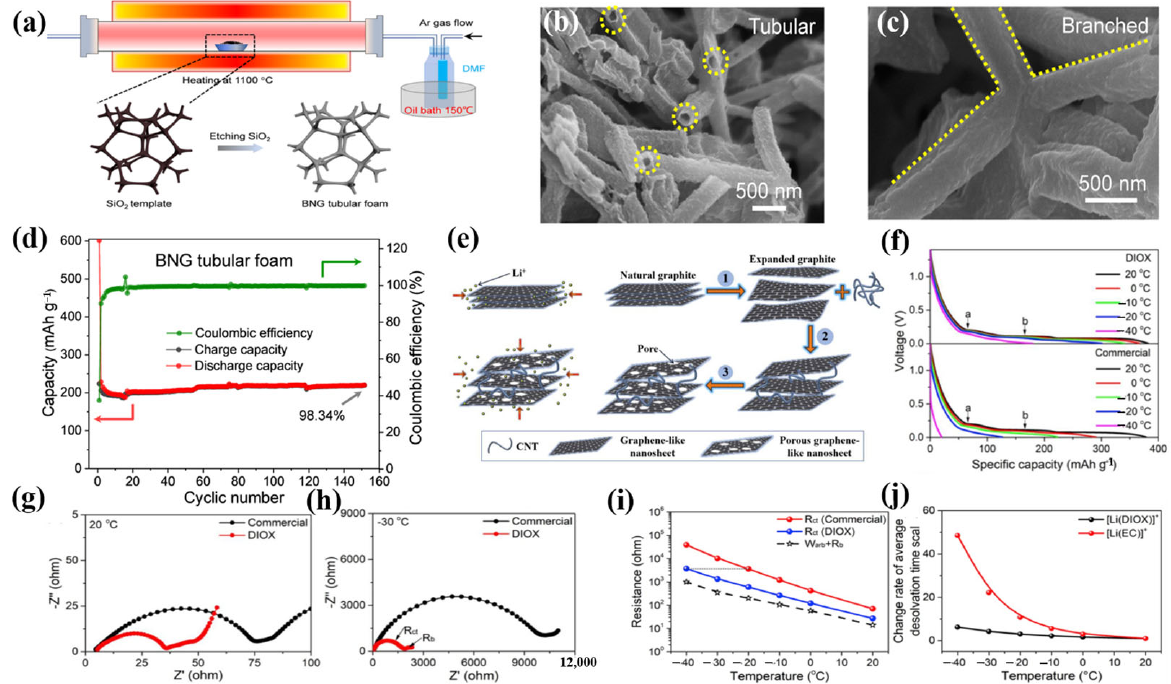
Figure 9. ( a ): Schematic diagram of the preparation of the BNG tubular foam using the self ‐ sacrifice template CVD method. ( b , c ): SEM images of BNG tubular foam. ( d ): Cyclic performance of BNG tubular foam at a current density of 0.1 C. ( a – d ) Reproduced with permission from [89]. ( e ): Sche ‐ matic illustration of the Li + insertion process for natural graphite and porous graphite nanosheet (PGN). ( f ): Voltage vs. Li + intercalation capacity over various temperatures at the 0.1 C rate in dif ‐ ferent electrolytes. ( g , h ): Nyquist plots of a PGN/CNT electrode measured at ( g ) 20°C and ( h ) − 30°C in different electrolytes. ( i ): Difference of temperature ‐ dependent resistance in different electrolytes. ( j ): Relative change rate of an average desolvation time scale of different solvated Li + at different temperatures. ( e – j ) Reproduced with permission from [49].